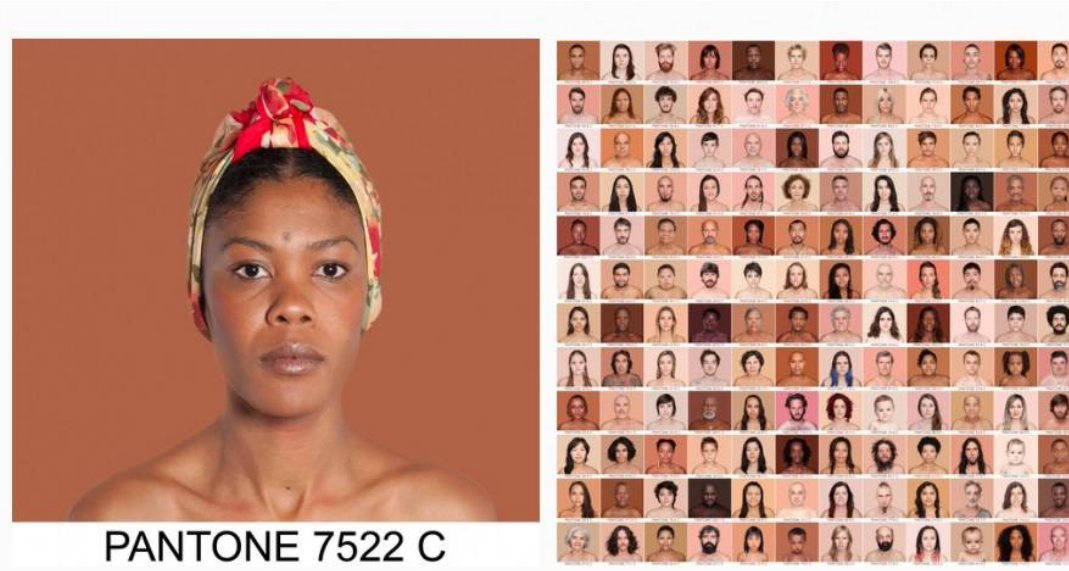
Figure 1. Angélica Dass portrait and some Humanae’s photos (Humanae: https://www.google.it/ search?q=HUMANAE&oq=humana&aqs=chrome.0.69i59j69i60j69i57j0l3.893j0j4&sourceid=chrome& ie=UTF-8). Courtesy of Angélica Dass .